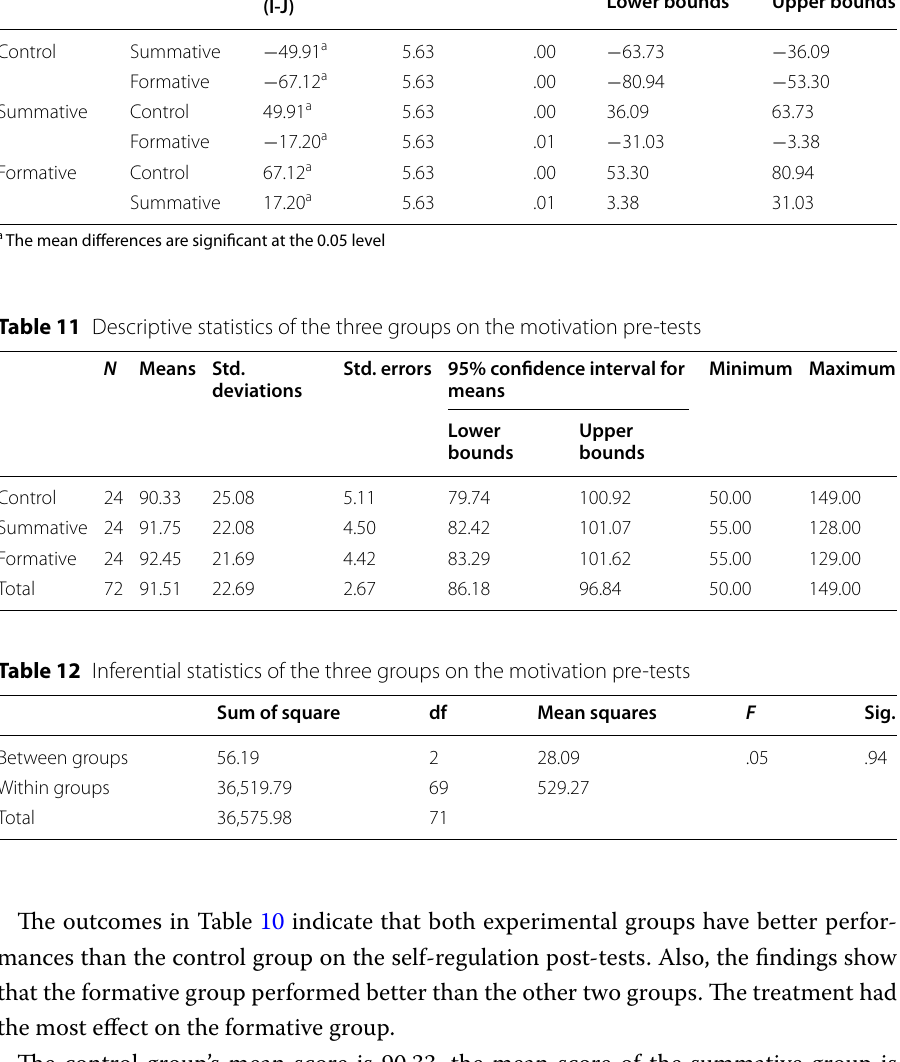
Table 10 Multiple comparisons by Bonferroni test (self-regulation)